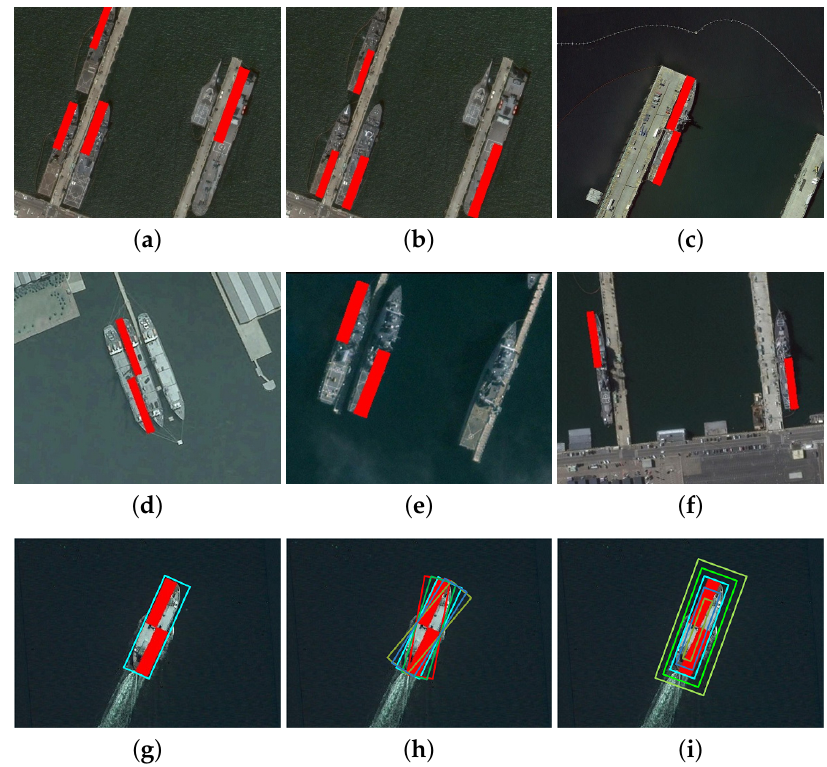
Figure 5. The illustration for rotated anchor generation. ( a , b ) are the top-left and bottom-right segmentation results, respectively. ( c – f ) show four different combination cases of the connected regions in the two segmentation results. ( g ) The initial rotated anchor can be generated via computing the minimum bounding box of the two connected regions. In ( h , i ), rotation and scaling are respectively performed to increase the number of the rotated